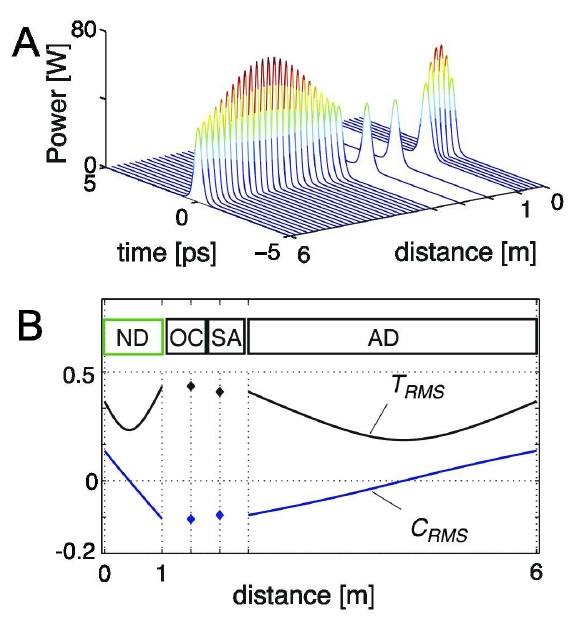
Figure 5: The evolutions of the (A) temporal profile, (B) power and chirp during one round trip in a stretched pulse fiber laser cavity. (Adapted from